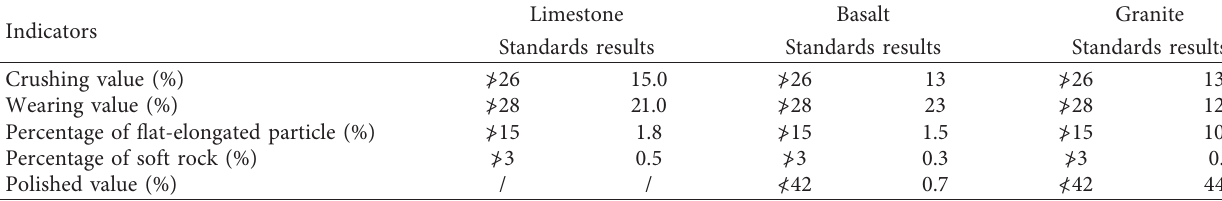
Table 1: The performance indicators of aggregate.